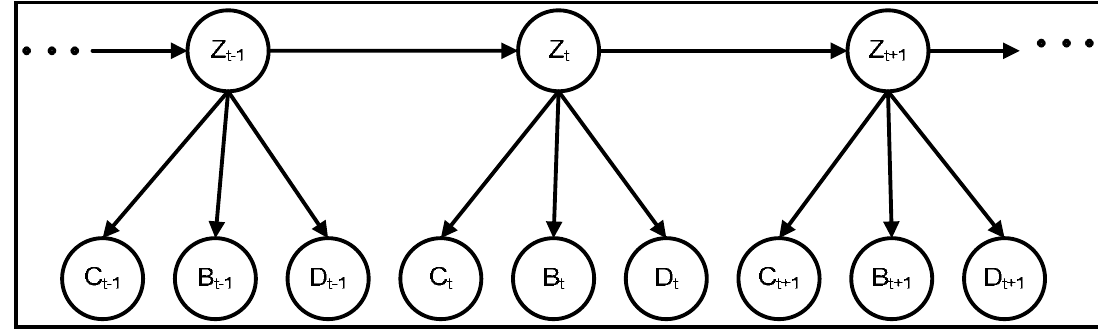
Figure 5. A Dynamic Bayesian Network